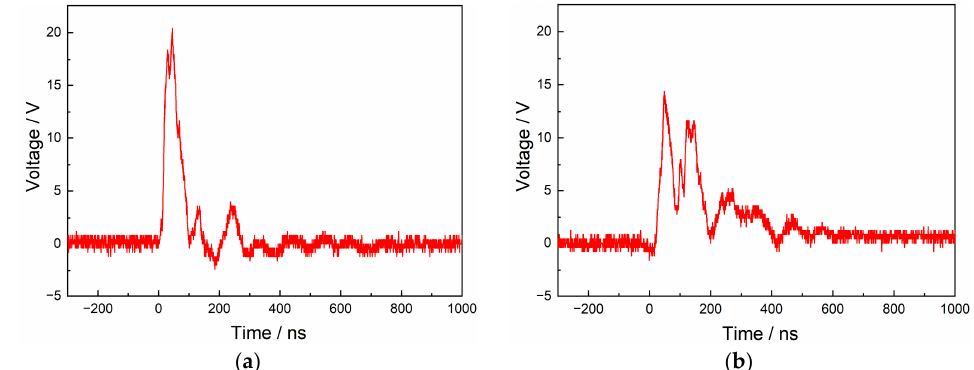
Figure 11. Electrostatic discharge waveforms of PI under 0.3 MeV electron radiation: ( a ) typical waveform; ( b ) sharp and large bifurcation waveform.